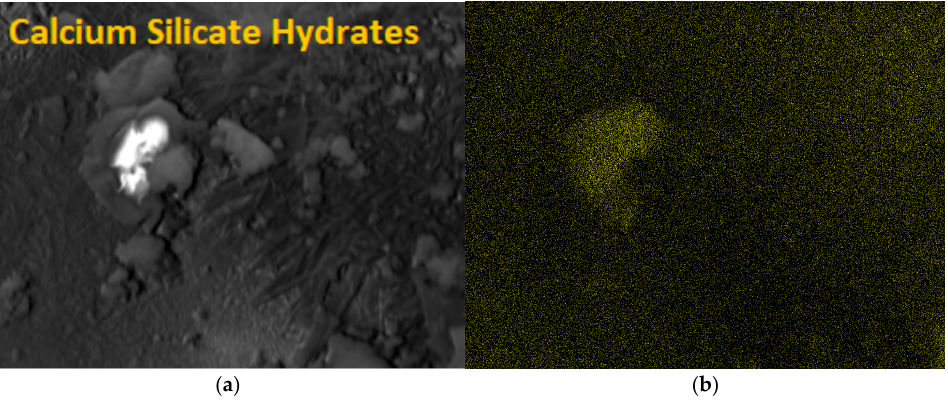
Figure 2. Photo of the microstructure of a silicate product made with a scanning electron microscope (SEM): ( a ) image of a sample of biohumus-modified silicate brick; ( b ) description of what is contained in the second panel. Figures should be placed in the main text near to the first time they are cited. A caption on a single line should be centered.